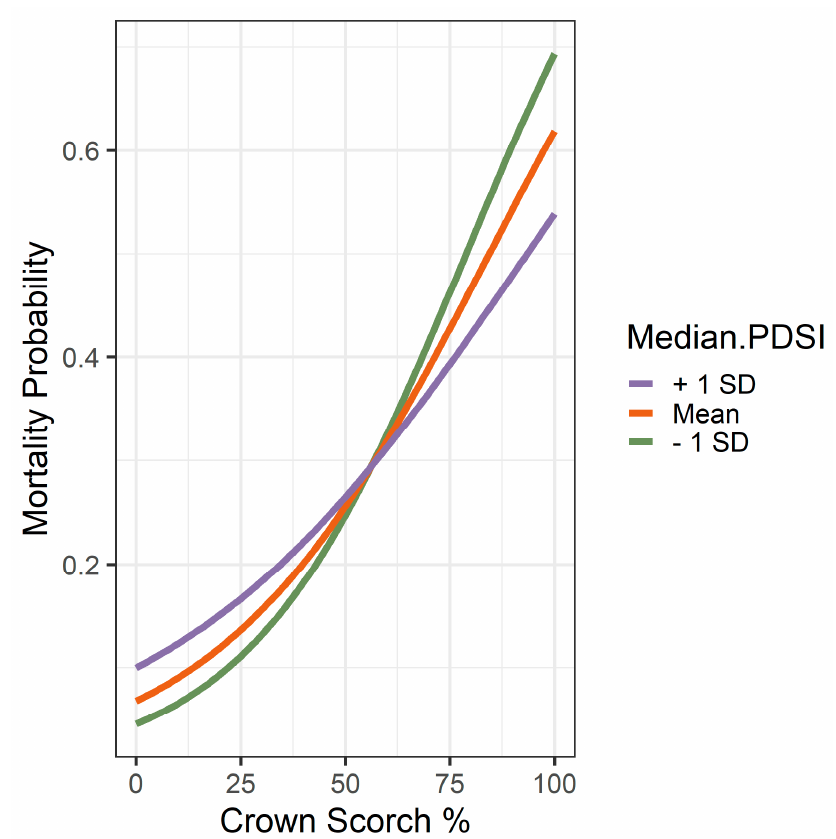
Figure 4. Interaction plot showing mortality risk at mean (+/ − sd) of median monthly PDSI across the range of crown scorch using R interactions package [32]. Median PDSI was-0.73 (0.2 sd) (see Table 2). Positive sd (+1 sd) indicates less drought exposure and negative sd ( − 1 sd) indicates in-